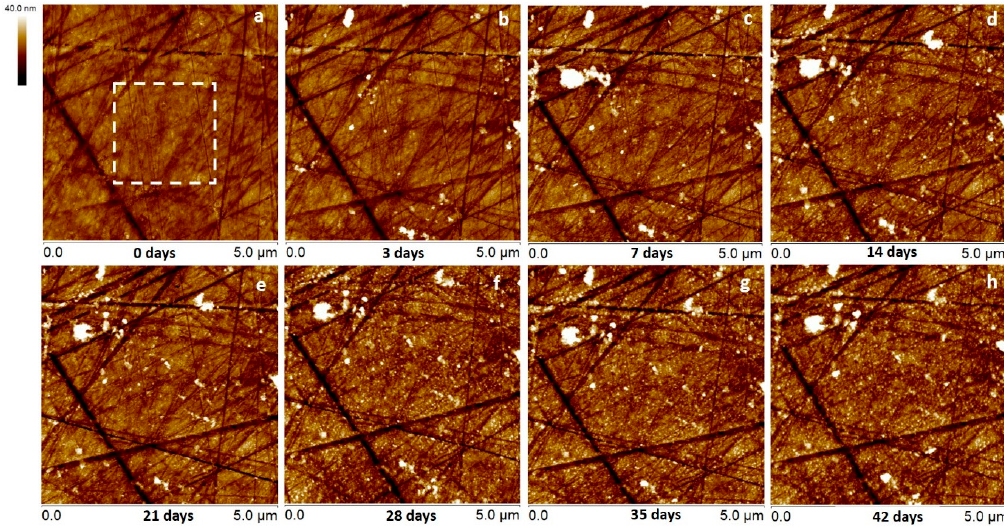
Figure 6. AFM images of a chalcopyrite (112) surface leached at pH 1 and in the presence of ferrous: 0 ( a ), 3 ( b ), 7 ( c ), 14 ( d ), 21 ( e ), 28 ( f ), 35 ( g ) and 42 ( h ) days.